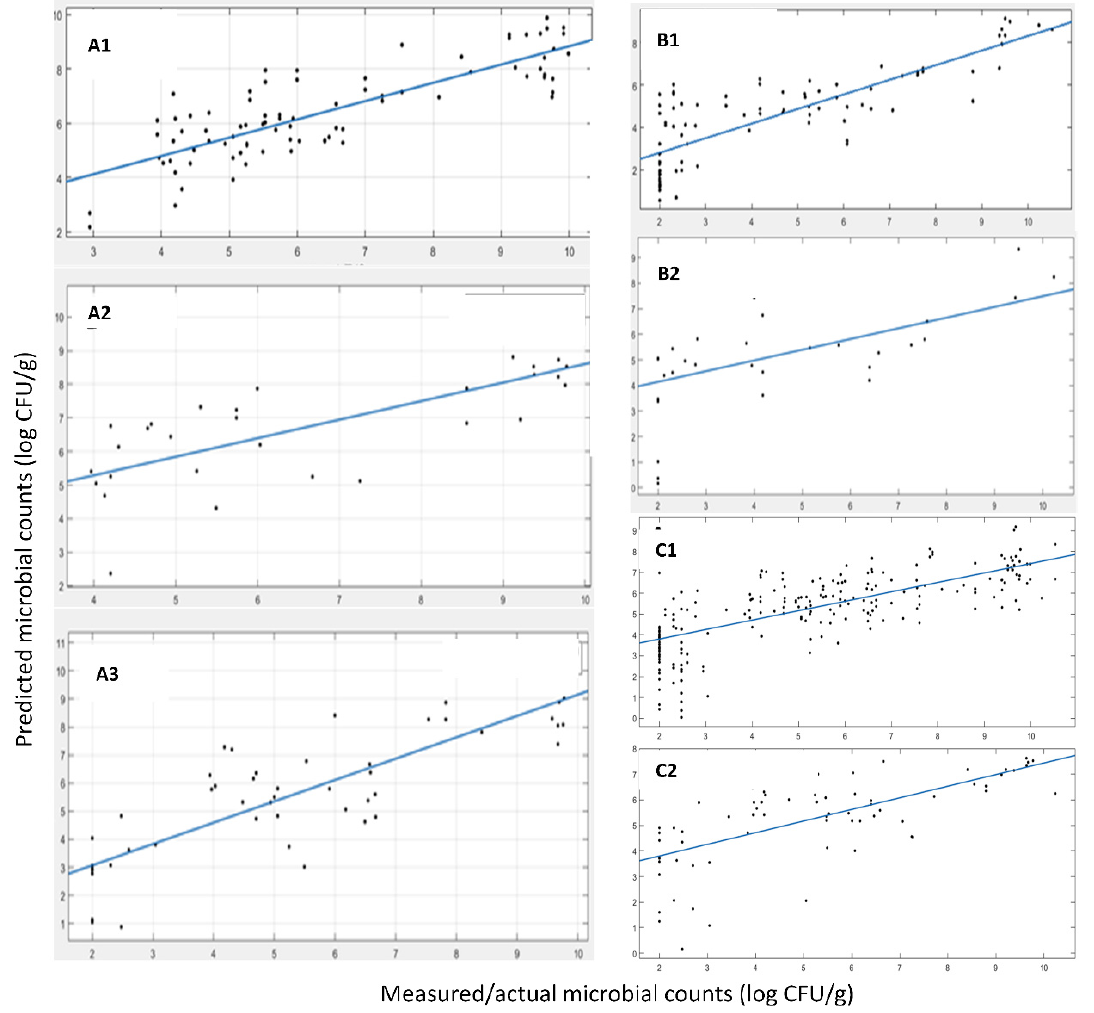
Figure 5. Linear regression between the predicted and the measured microbial counts using e-nose data. (A1) cross validation MI samples, (A2) test/external validation from harvest 2019 and 2020 MI samples, (A3) test/external validation from harvest 2019, 2020 and 2021 MI samples, (B1) cross validation SAMS samples, (B2) test/external validation SAMS samples, (C1) cross validation, (C2) test/external validation MI+SAMS samples.